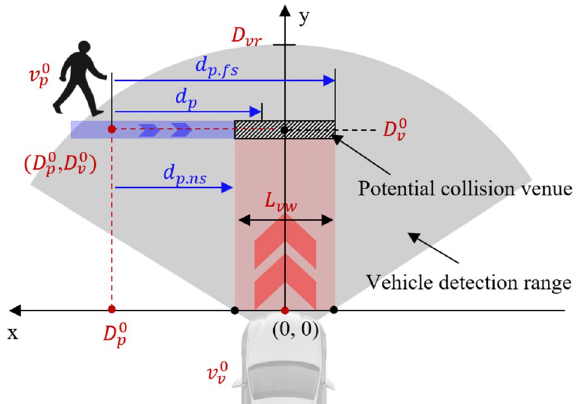
Figure 7. Illustration of the pedestrian motion in the on-vehicle coordinate system. The centre of the vehicle front-end is taken as the origin. D vr denotes the radius of the detection range for typical vehicle sensing